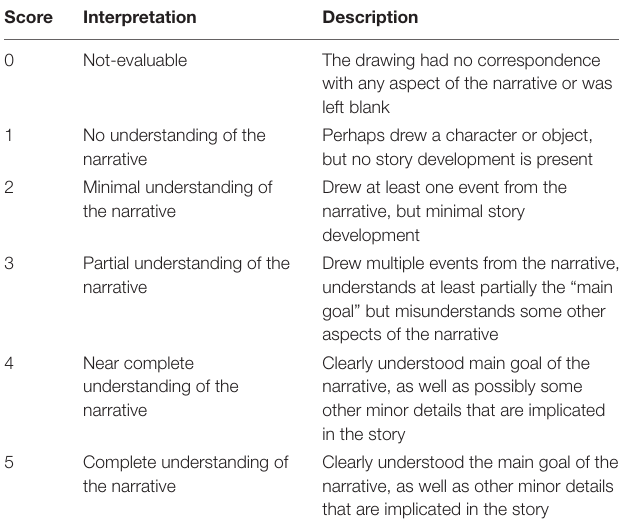
TABLE 3 | The scoring rubric to evaluate